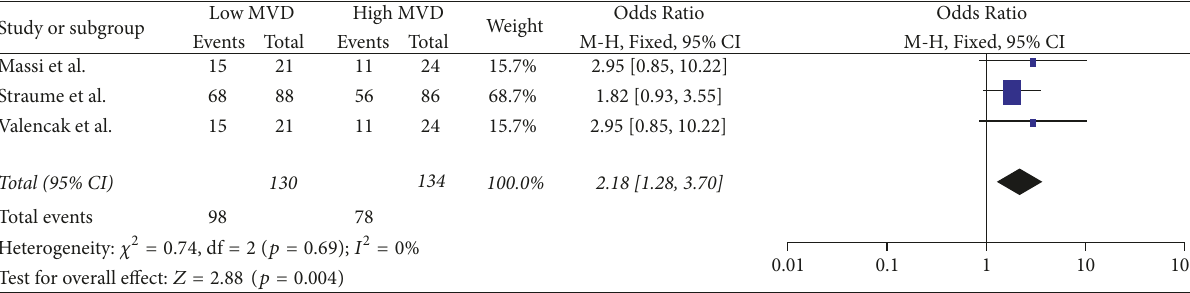
Figure 9: 36 months’ disease-free survival.